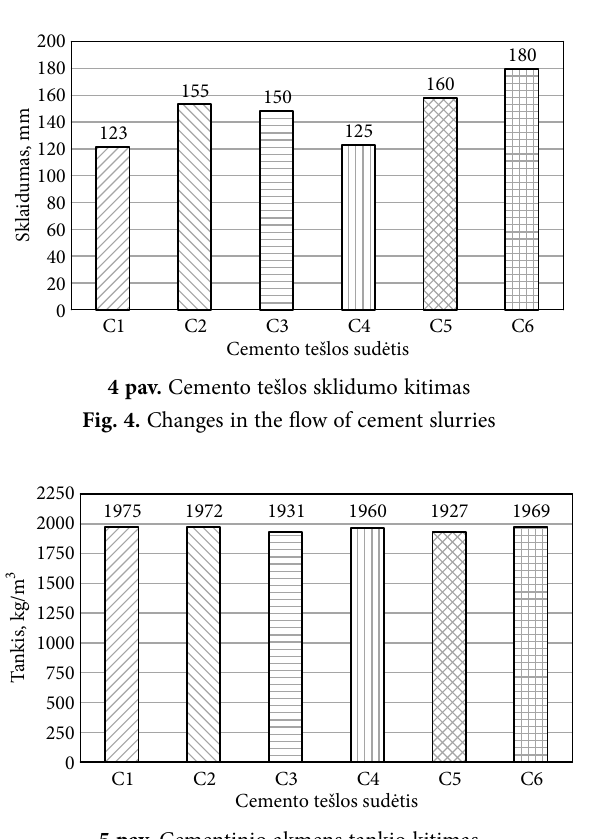
5 pav. Cementinio akmens tankio kitimas Fig. 5. Changes in the density of hardened cement paste